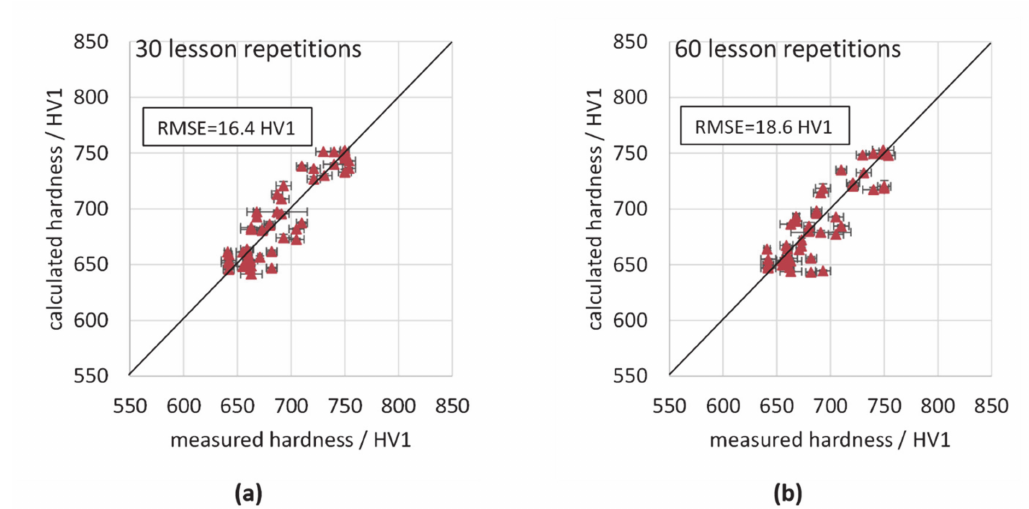
Figure 13. Correlation of micromagnetic determined and actual measured hardness of the test data set after 30 ( a ) and 60 ( b ) repetitions of the training lesson using ANN.